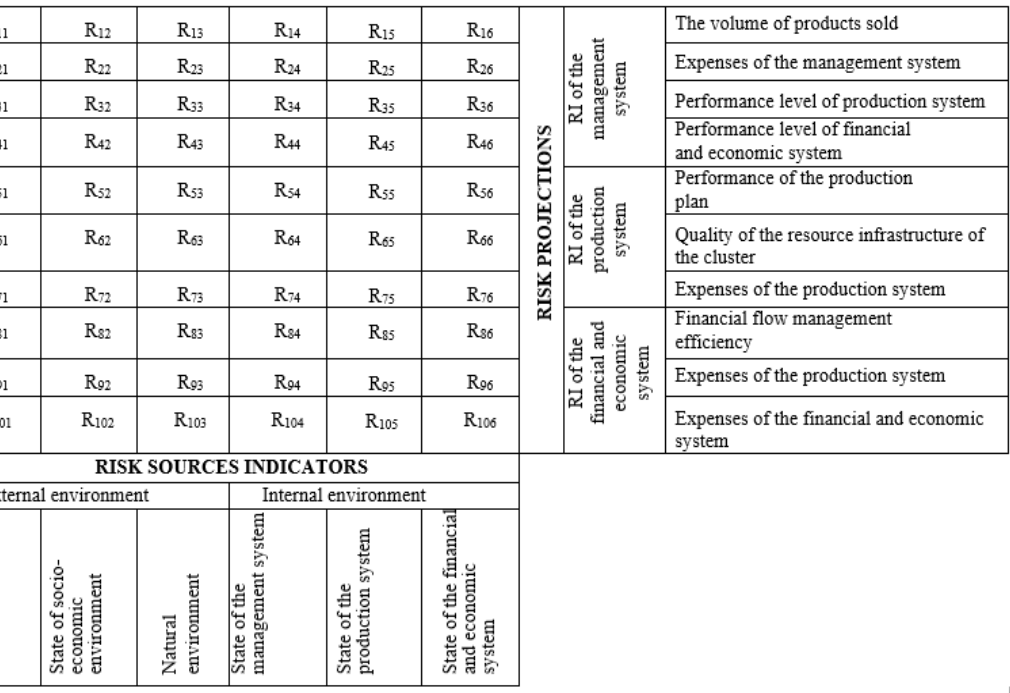
Figure 2. Basic systems of the cluster enterprise according to the functional-target approach. Devel- oped by Izmalkova I.